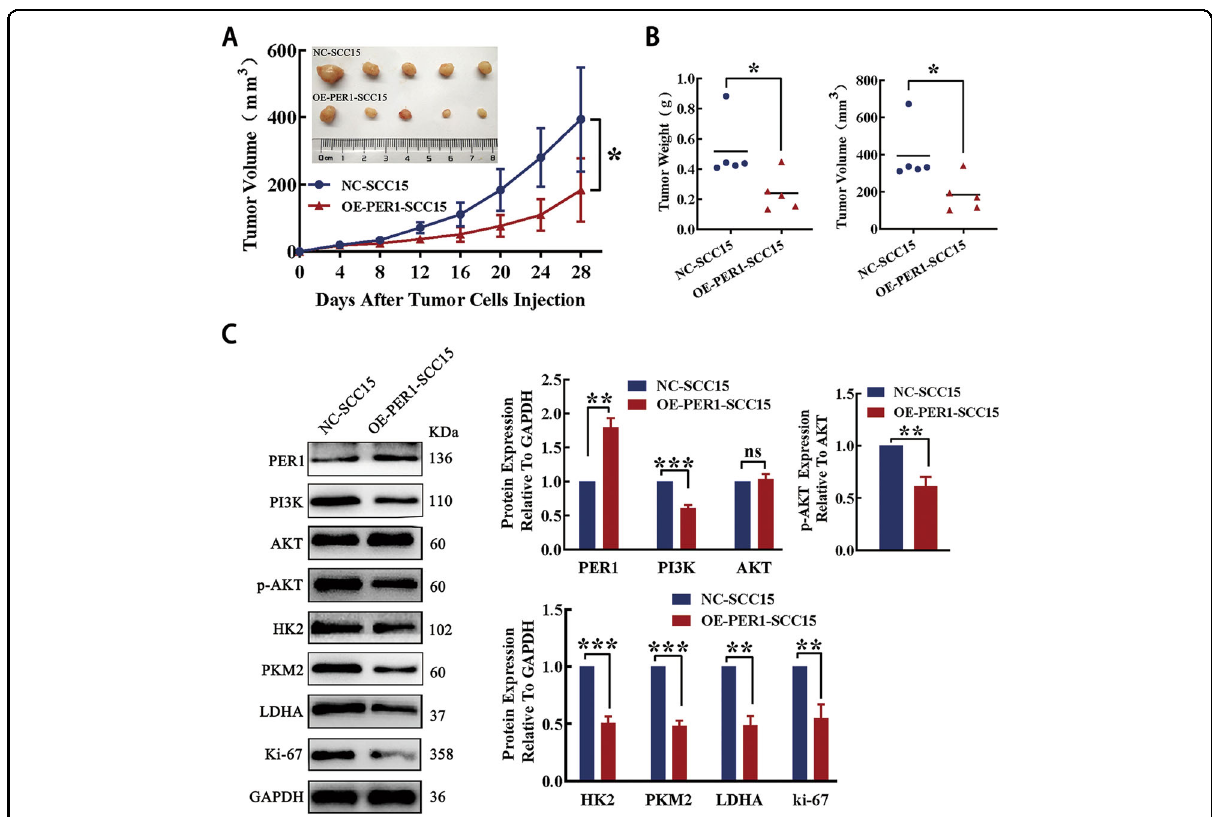
Fig. 7 In vivo tumorigenicity. A The curve of tumor growth in nude mice showed that the tumor formation rate in the OE-PER1-SCC15 group was signi fi cantly lower than that in the NC-SCC15 group. B The tumor weights and volumes in the OE-PER1-SCC15 group were signi fi cantly lower than those in the NC-SCC15 group. C Western blotting showed that the expression of PER1 in the OE-PER1-SCC15 group was signi fi cantly higher than that in the NC-SCC15 group, while the levels of PI3K, p-AKT, HK2, PKM2, LDHA, and Ki-67 in the OE-PER1-SCC15 group were signi fi cantly lower than those in the NC-SCC15 group. All data are from three independent experiments. The data are presented as the mean ± SD values ( n ≥ 3). * P < 0.05; ** P < 0.01; *** P < 0.001; **** P <